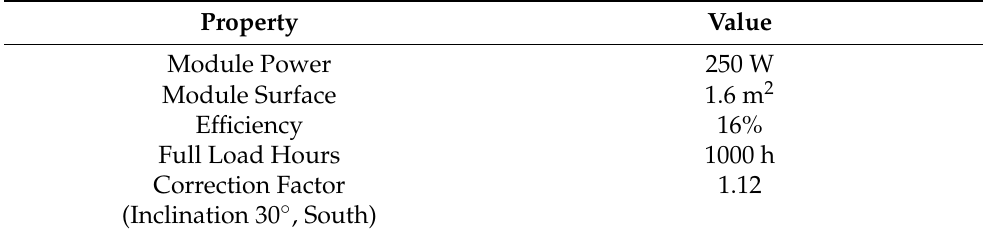
Table A1. Specifications of implemented standard PV